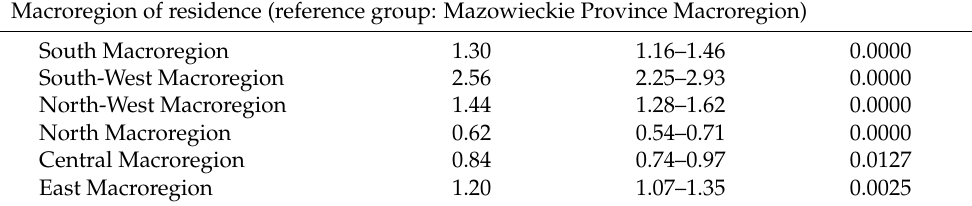
Table 2. Visits of women with PCOS to AOS in relation to age and macroregion of residence.